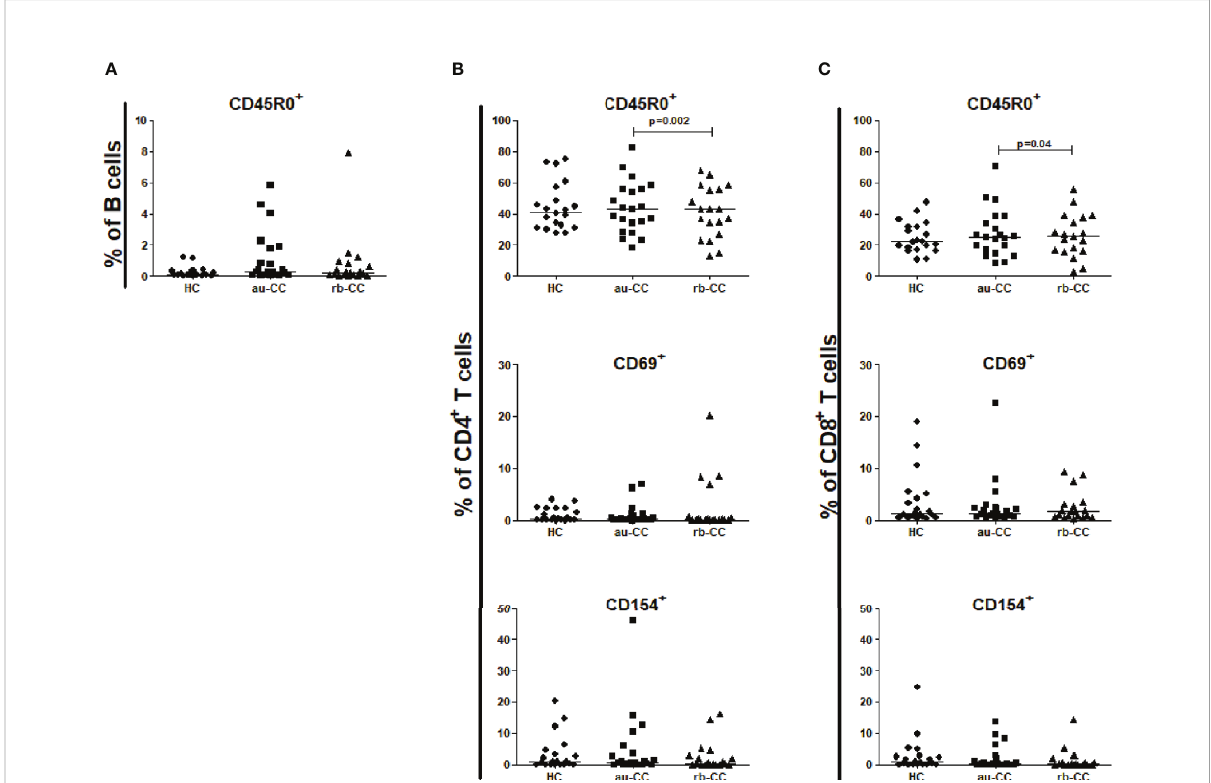
FIGURE 3 Frequencies of peripheral activated and memory subpopulations of B lymphocytes (A) , CD4+ T helper cells (B) and CD8+ cytotoxic T cells (C) in collagenous colitis. Analysis performed with fl ow cytometry. Statistically signi fi cant differences are p<0.01, statistical trends are p<0.05. au, active/untreated; CC, collagenous colitis; HC, healthy controls; rb, remission/budesonide. CD69 and CD154 are activation markers and CD45R0 memory